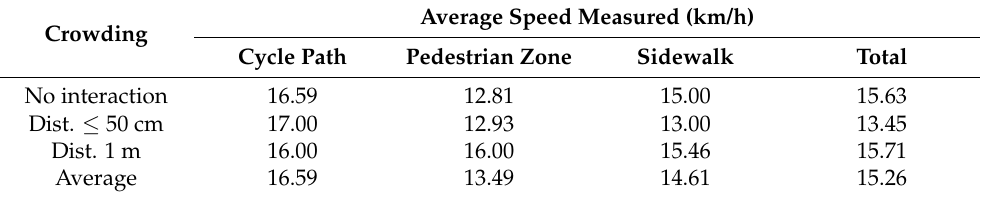
Table 6. Relations between the variables crowding, path, and speed.